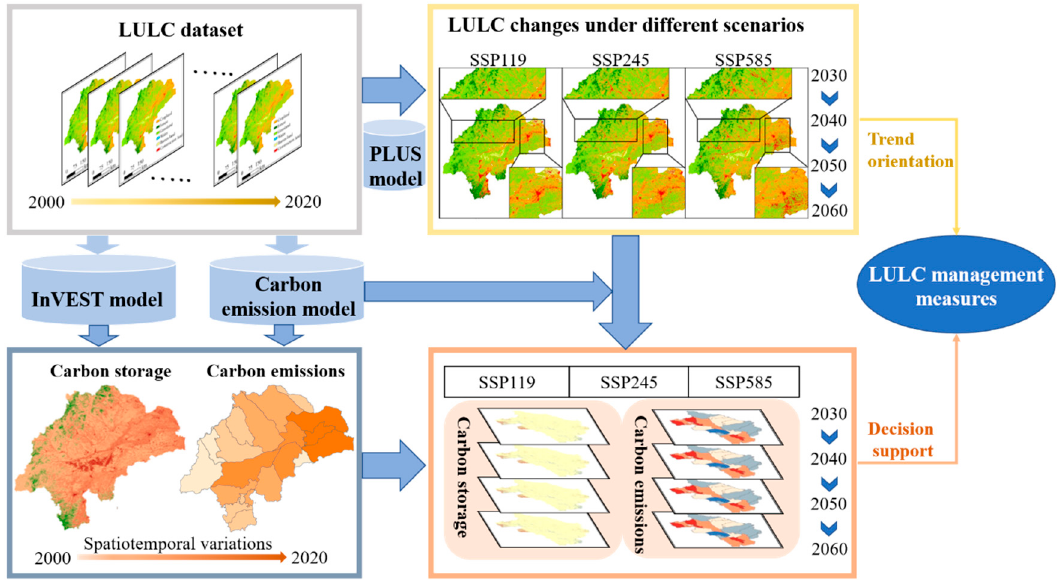
Figure 2. The research framework of this paper.